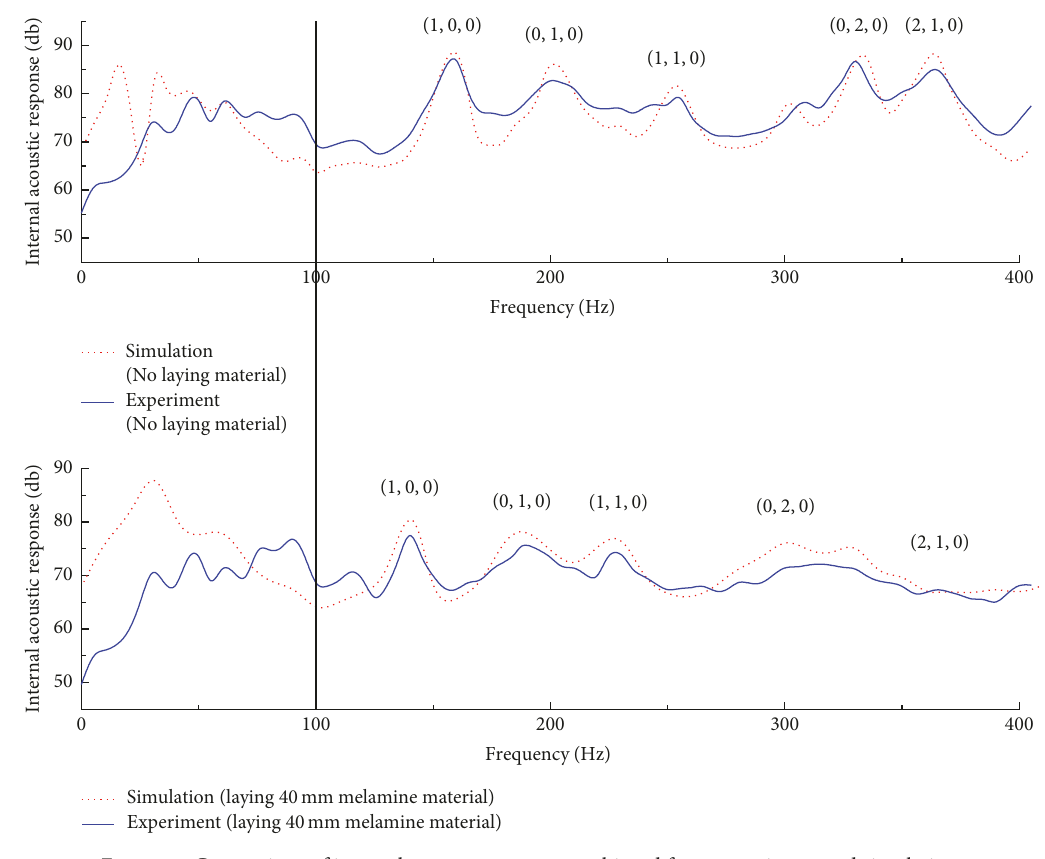
Figure 5: Comparison of internal response spectrum achieved from experiment and simulation.